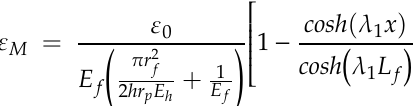
Table 1. Material properties of the optical fiber, protective coating, adhesive and host structure. Young’s modulus of optical fiber E f = 72 GPa radius of optical fiber r f = 62.5 µ m Young’s modulus of coating E p = 6.7 MPa Young’s modulus of adhesive E a = 2 GPa Young’s modulus of host structure E h = 72 GPa Poisson’s ratio of optical fiber ν f = 0.17 Poisson’s ratio of coating ν p = 0.49 Poisson’s ratio of adhesive ν a = 0.4 gap b / r p = 0.2 Poisson’s ratio of host structure ν h = 0.3 refractive index of optical fiber n 0 = 1.456 shear modulus of coating G p = 2.2